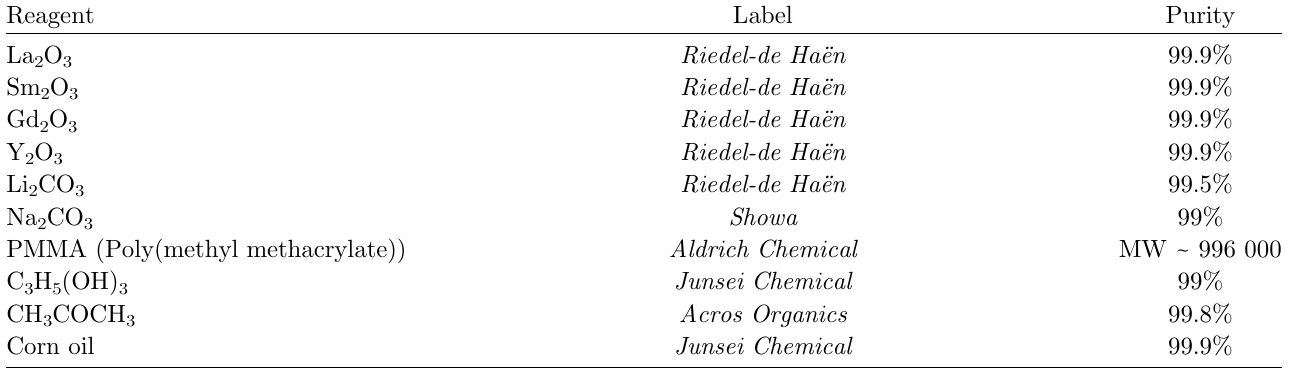
Table 1. Chemicals used in this study.